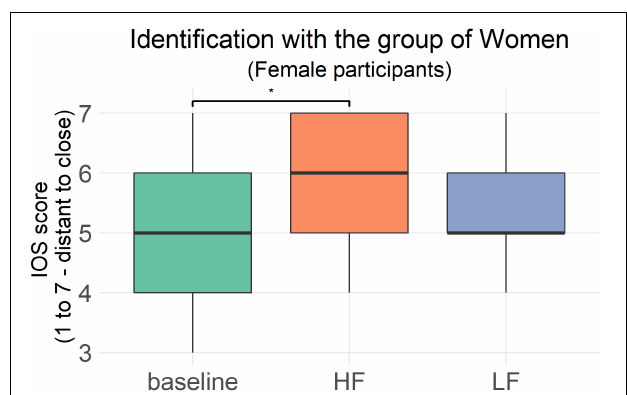
FIGURE 4 | Answers of the women ( n = 25) to the IOS scale for the group of women at the three points of measurement. The horizontal bar represents the median IOS score. A higher score indicates a closer relationship between the self and the group of women. * p ≤